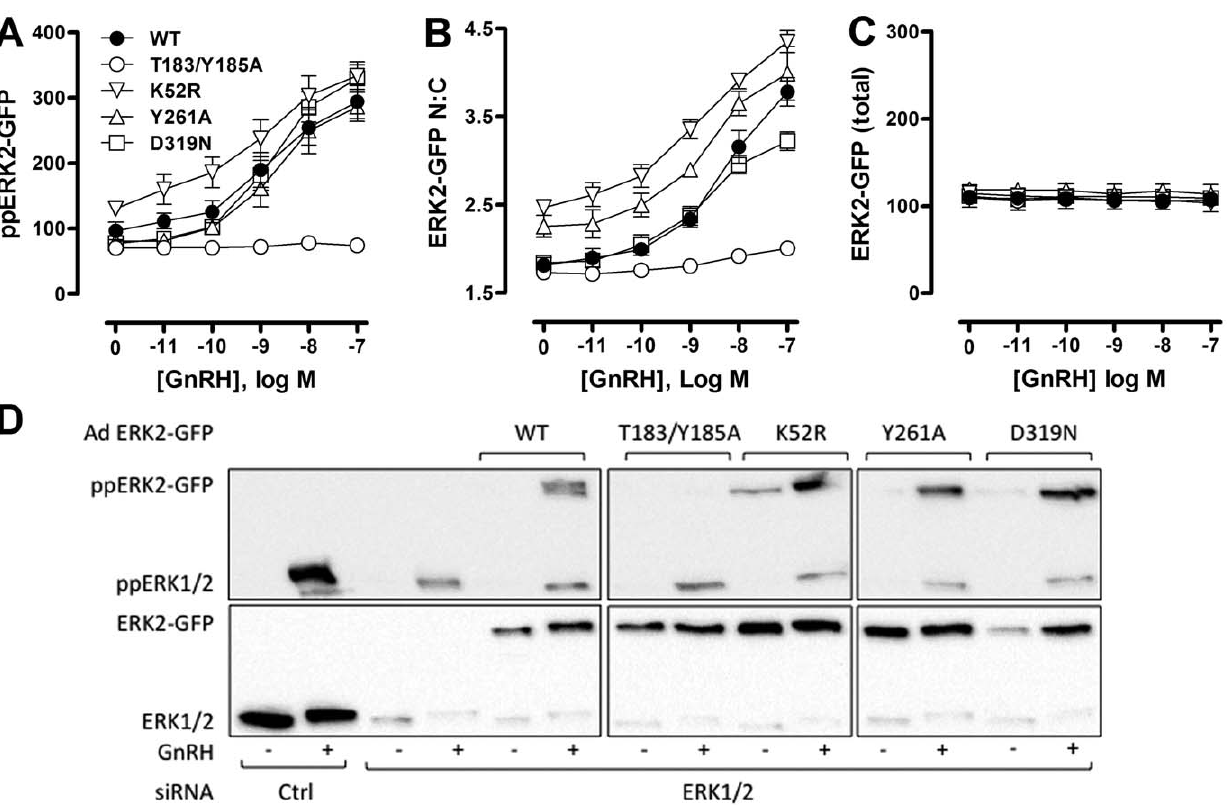
Figure 7. Phosphorylation, catalysis and docking domains control ERK targeting in response to GnRH. HeLa cells transfected with ERK siRNAs (to knock-down endogenous ERK) and were transduced with Ad to add-back wild-type (WT), K52R, T183/Y185A, Y261A or D319N-mutated ERK2-GFP. They were then stimulated with GnRH as indicated for 5 minutes before fixation, ppERK2-GFP staining, image acquisition and analysis as described in Methods, to assess whole-cell levels of TEY-phosphorylated ERK2-GFP (ppERK2-GFP in AFU, panel A), nucleo-cytoplasmic distribution of ERK2-GFP (ERK2-GFP N:C, panel B) and whole-cell levels of ERK2-GFP in the nucleus and cytosol (total ERK2-GFP, panel C). Data are population average means 6 SEM (n=7) Two way ANOVAs of data in panel A revealed GnRH as a significant source of variation, as were the T183/Y185A and K52R mutations (P , 0.05) and post-hoc Bonferroni tests revealed significant differences between WT and T183/Y185A-ERK2 expressing cells at 1, 10 and 100 nM GnRH (P , 0.05). Two way ANOVAs of the panel B data revealed GnRH and all 4 mutations as significant variables (P , 0.01). Post-hoc Bonferroni tests revealed significant differences (P , 0.05) between WT- and T183/Y185A-ERK2 expressing cells at 1, 10 and 100 nM GnRH, between WT- and K52R-ERK2 expressing cells at all GnRH concentrations, between WT- and Y261A-ERK2 expressing cells at 1 nM GnRH, and between WT- and D319N-ERK2 expressing cells at 100 nM GnRH. Similar analysis of the panel C data revealed that neither GnRH nor mutant expressed were significant sources of variation (P . 0.05). For panel D, HeLa cells cultured in 12 well plates were transfected with ERK siRNAs (to knock-down endogenous ERK) or with control siRNAs (Ctrl) and were transduced with Ad to add-back wild-type (WT), K52R, T183/Y185A, Y261A or D319N-mutated ERK2-GFP. They were then stimulated without or with GnRH ( 2 / + , as indicated) for 5 minutes before whole cell protein extraction, and western blotting for ppERK and for total ERK (ERK1 and/or 2) as indicated. The data shown are from an experiment that is representative of 3 such experiments.